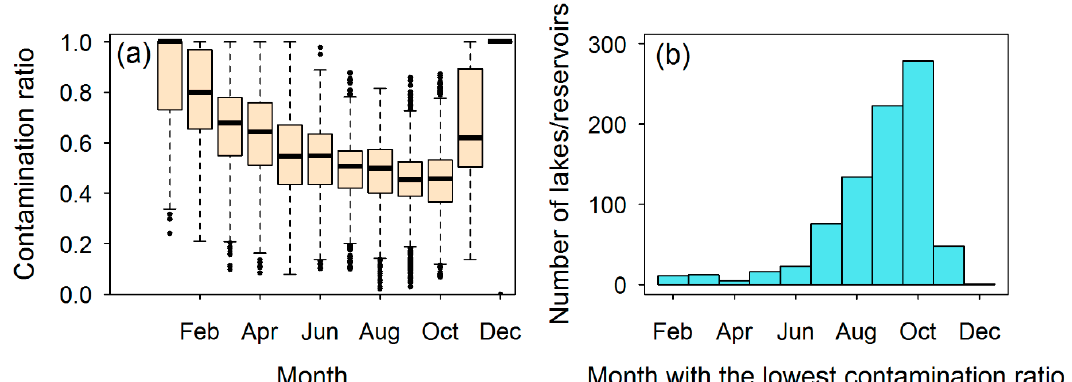
Figure 3. Determination of month of analysis. ( a ) Boxplots of contamination ratio of 829 lakes and reservoirs by month, 1984–2015. ( b ) Histogram on the month with the lowest contamination ratio for 829 lakes and